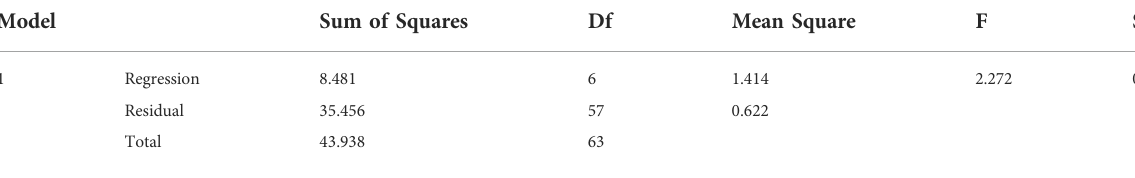
TABLE 17 ANOVA corresponding to the dependent variable for Pse.